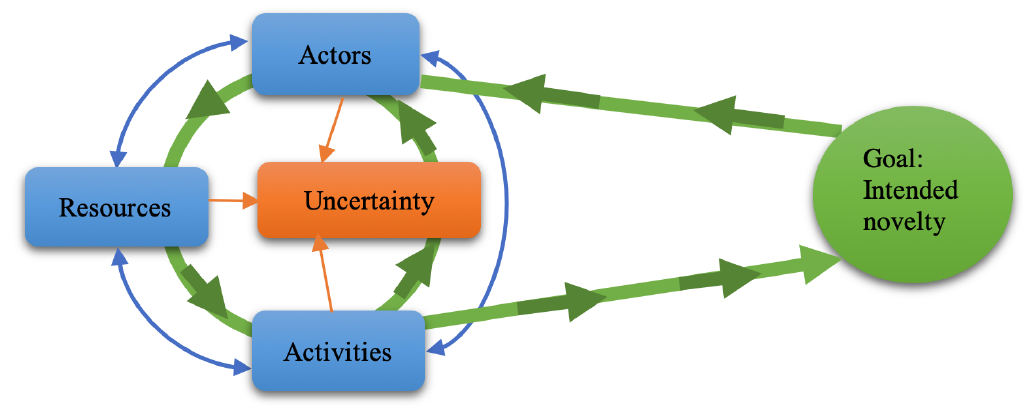
Fig. 1. The uncertainty-embedded innovation process model (Author’s